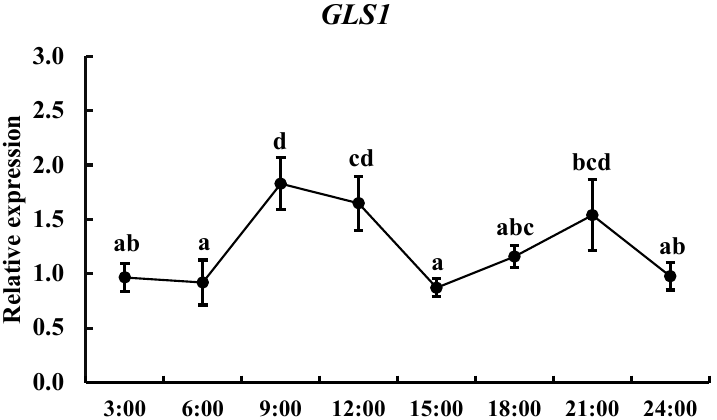
Figure 3. The relative expression of TCC gls1 in the heart, gut, liver, brain, kidney, spleen, and mus ‐ cle. Different letters represent significant difference ( p < 0.05, n = 9 for each bar). The circadian rhythm of muscle gls1 mRNA was presented in Figure 4. gls1 expres ‐ sion showed a downward trend from 9:00 to 15:00, and an upward trend from 15:00 to